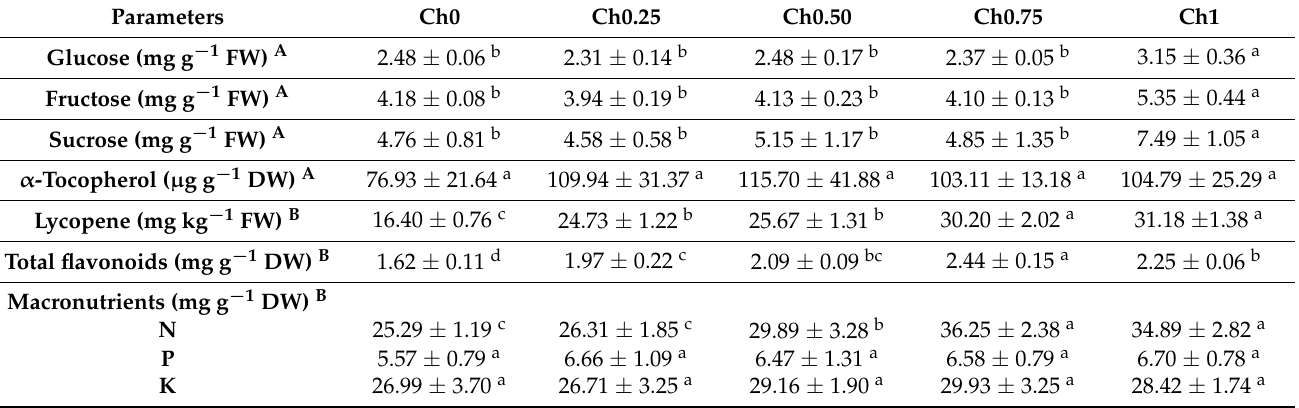
Table 3. Chitosan effects on the levels of sugars, vitamin E, lycopene, and flavonoids as well as the acquisition of macronutrients.